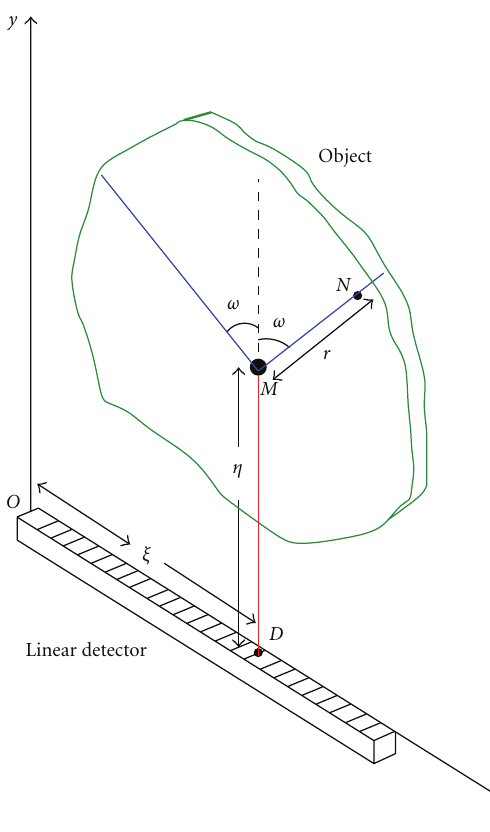
Figure 1: Experimental setup and definition of